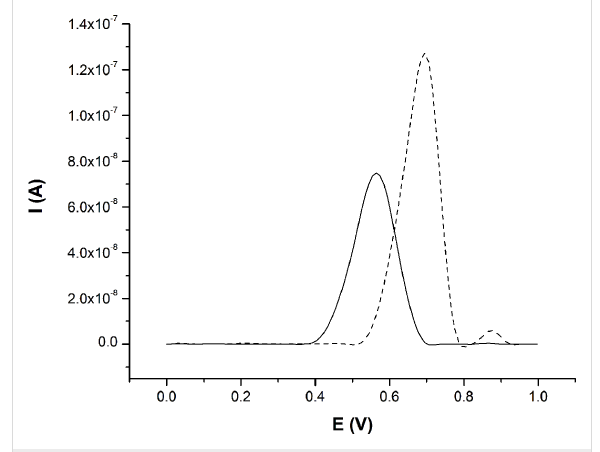
Figure 7: DPV-traces (with baseline correction) of 0.5 mM solutions of 4a (solid) and 4b (dash) in DMF, with SP = 10 mV and MA = 50 mV in the 0.0 V to 1.0 V potential